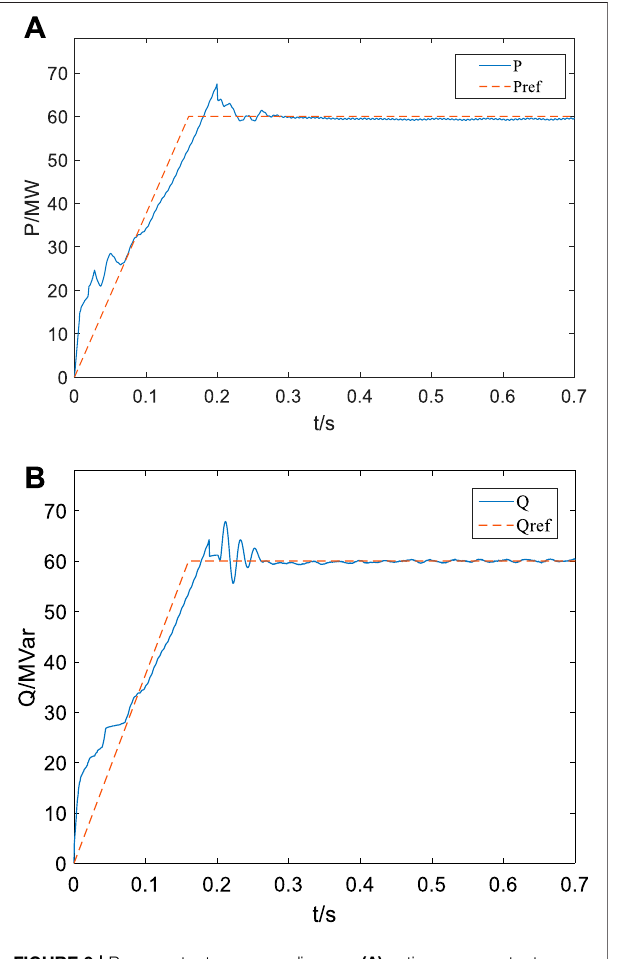
FIGURE 9 | Power output response diagram: (A) active power output response diagram and (B) reactive power output response diagram.